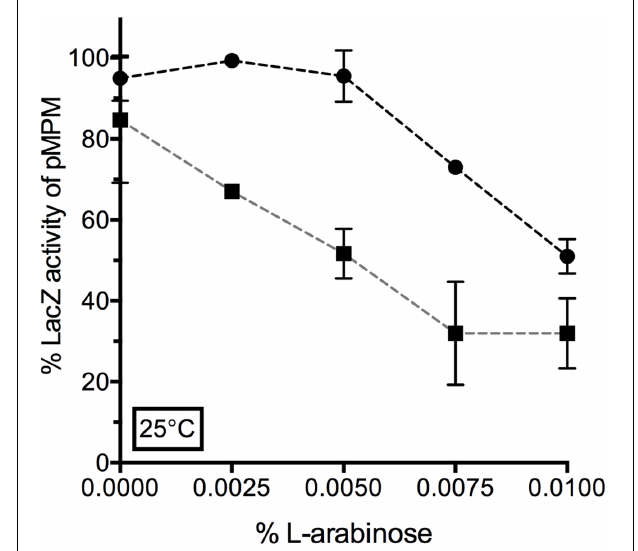
FIGURE 7 | Lon-dependent repression of P ompF-lacZ by YcgZ. YcgZ was expressed using the pDVMZ vector in VDL103 ( ycgZ-ymgABC VDL104 ( lon bluR ycgZ-ymgABC (cid:4) ) strains. Cells were grown at 25 ◦ C in LB medium supplemented with increasing concentration of L -arabinose. LacZ activity was measured when the culture reached exponential phase (optical density at 600 nm ∼ 0.6) and is expressed as a percentage of the LacZ activity measured for the strain carrying the empty pMPM plasmid. The values represent the mean and the standard deviations of a least three independent